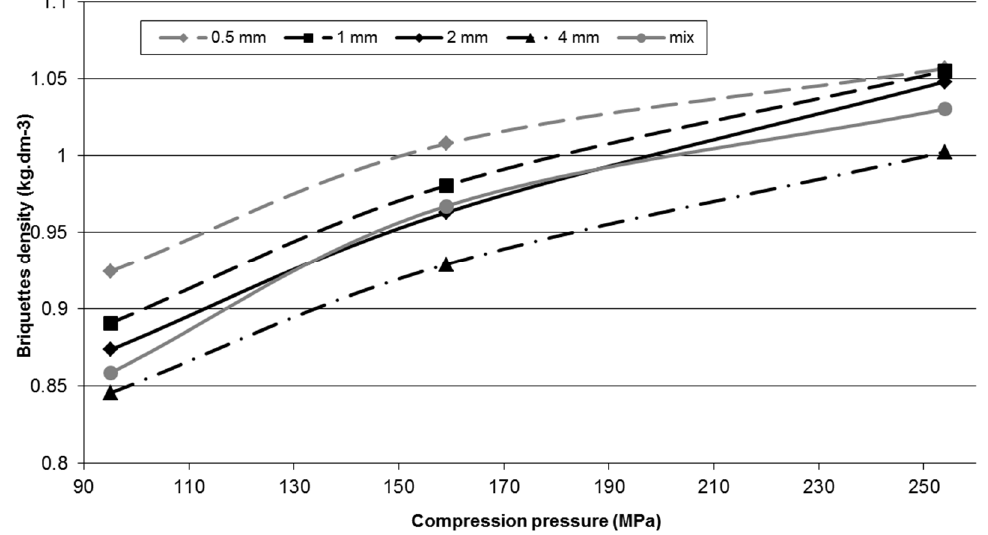
Figure 17. Relation between briquette density and compression pressure for different particle sizes ( w r = 8%; T = 25 °C).